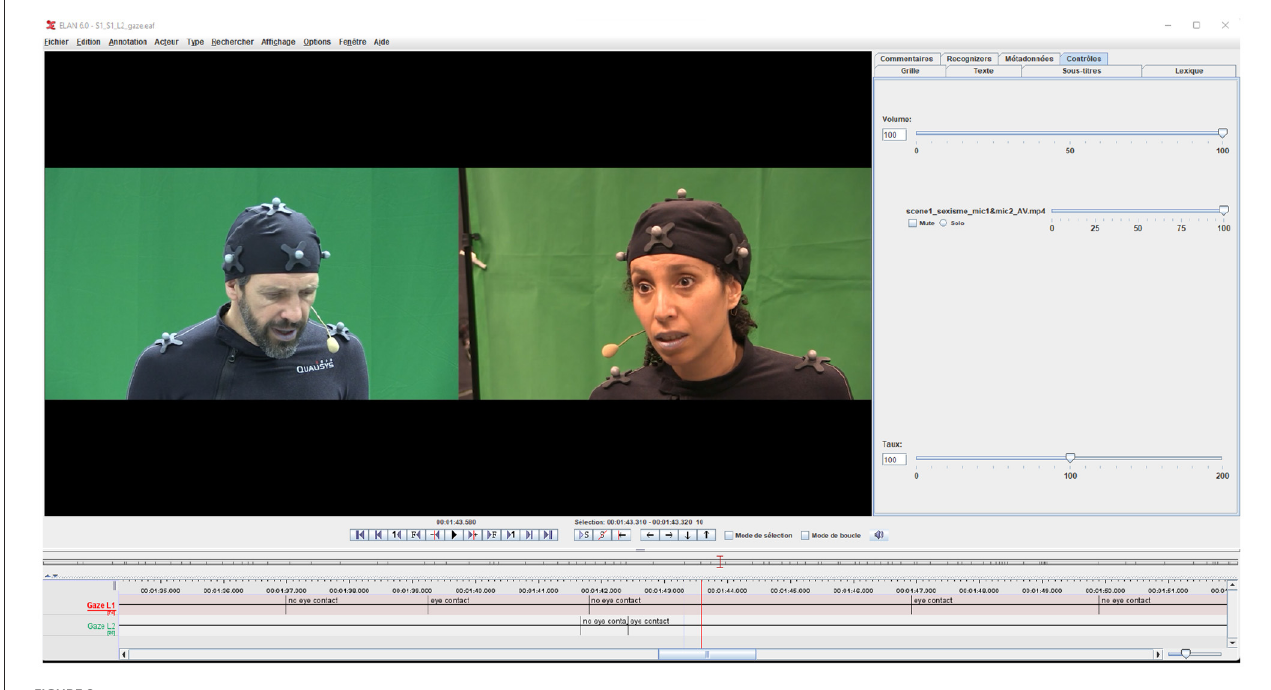
FIGURE8 Screenshot of the ELAN tool used for the annotation of the gaze direction.